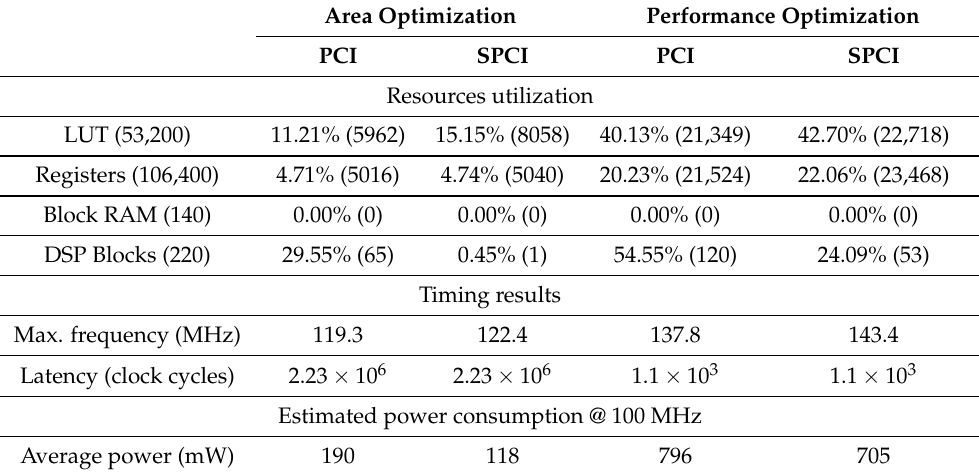
Table 1. Comparison of correlation methods implemented in SoC/FPGA target. Resource utilization and timing characteristics are summarized according to post-implementation reports. The figures in this table correspond only to the IP correlation indices. Two types of optimizations are summarized for each correlation IP core: area and performance. The area optimization resulted in fewer resources utilization, whereas the performance optimization provided higher throughput and reduced latency. A great advantage in computational resources is evident for SPCI compared to PCI, particularly considering the reduced DSP blocks utilization and power